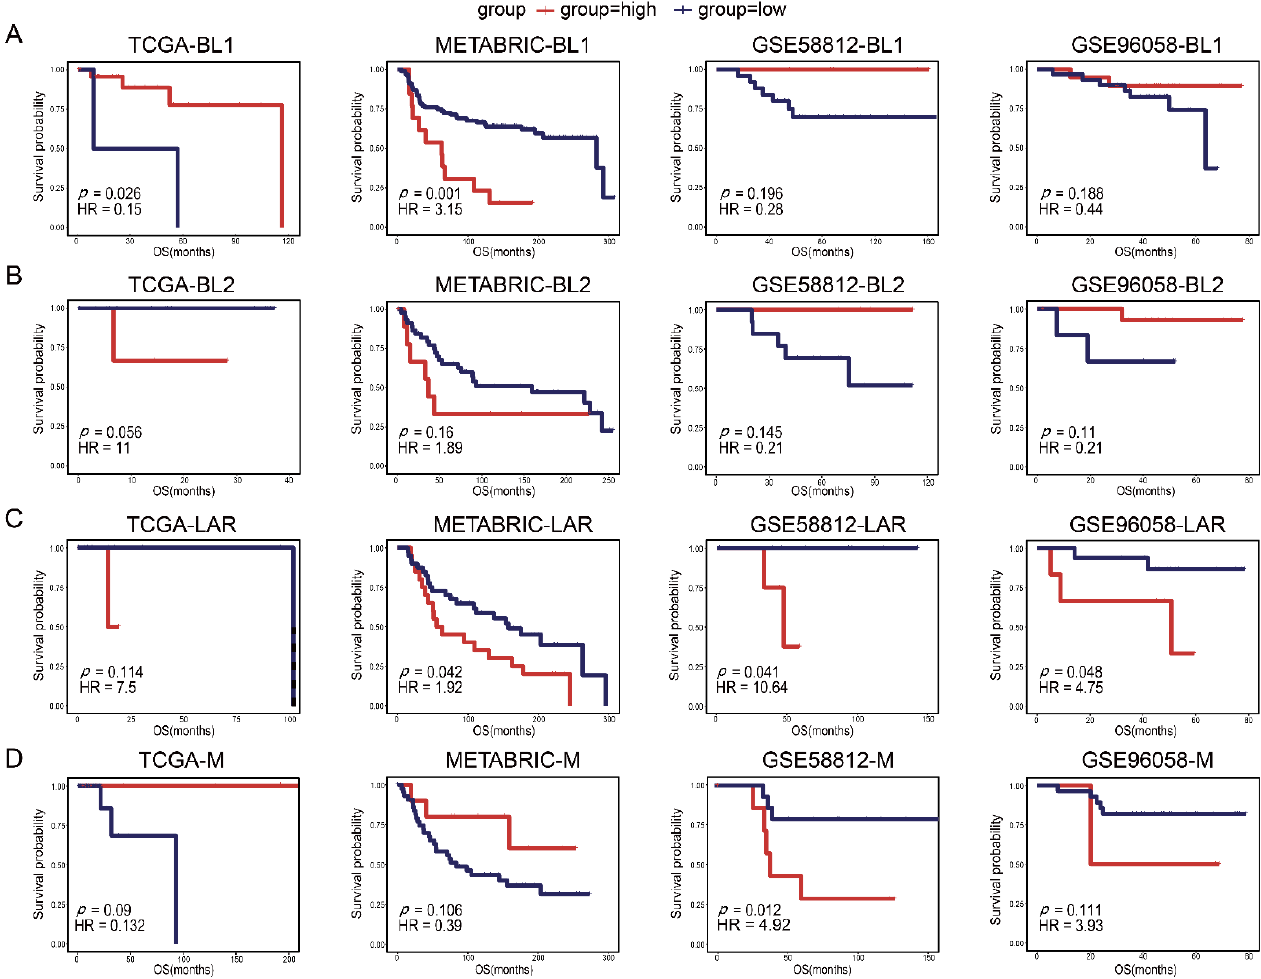
Figure 3. Kaplan-Meier survival curves of the OS between the high-risk and low-risk patients with each TNBC subtype in four validation datasets (TCGA, METABRIC, GSE58812, and GSE96058). ( A ) BL1-subtype, ( B ) BL2-subtype, ( C ) LAR-subtype, ( D ) M-subtype.